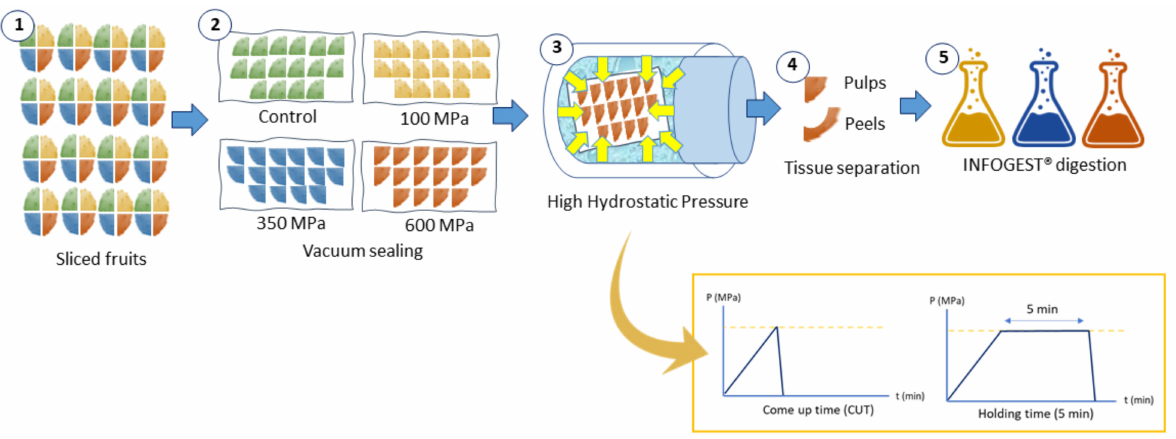
Figure 1. Separation scheme of prickly pear fruit sliced quarters to process with high hydrostatic pressure (HHP) at 100, 300, and 600 MPa and evaluate the effect of the come-up time (CUT) and holding time at each